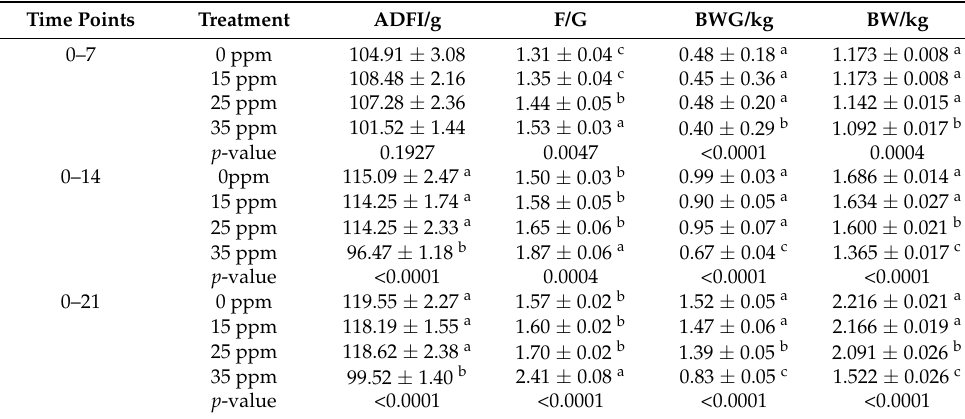
Table 2. Growth performance indices of AA broilers in different